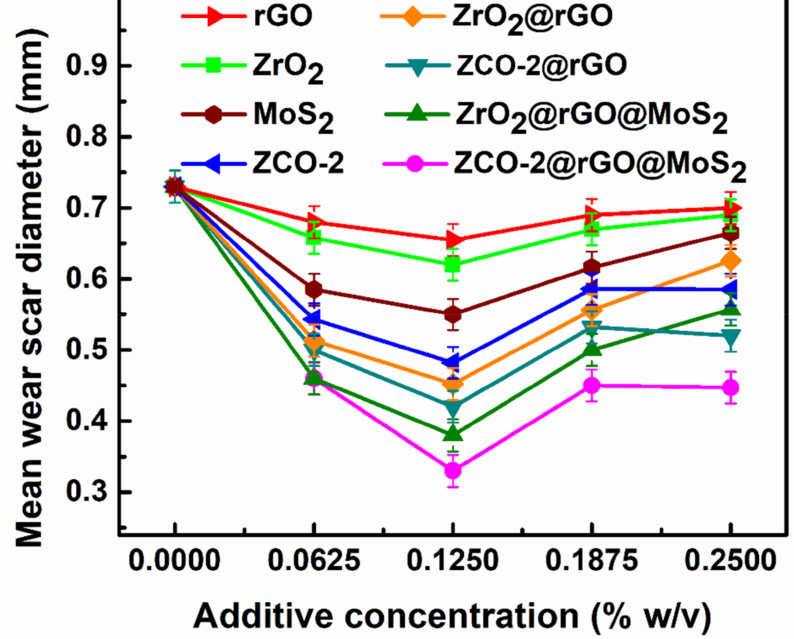
Figure 5. Variation of mean wear scar diameter for the para ffi n oil as a function of additive concentration at 392 N applied load for 60 min